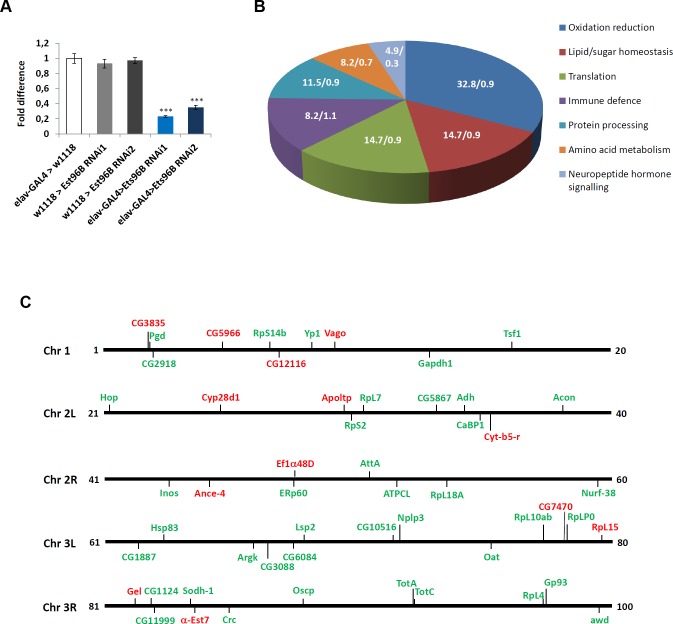
Ets96B regulates genes involved in oxidative phosphorylation and redox reactions (A) Relative expression level of Ets96B in 5–7 day old control males or males where Ets96B was knocked down in the entire nervous system throughout development. This assay was repeated at least 7 times. (n = 25 males per treatment; ** P<0.005 compared with controls, one-way ANOVA with Tukey’s post hoc test for multiple comparisons). Error bars = SEM. (B) Pie chart showing KEGG classification of gene groups (percentage of total Ets96B up or down regulated genes /percentage of all genes in the genome belonging to a particular category). (C) Drosophila genome depicting the location of genes up (green) or down (red) regulated in Ets96B SOLiD sequencing of the entire Drosophila transcriptome.